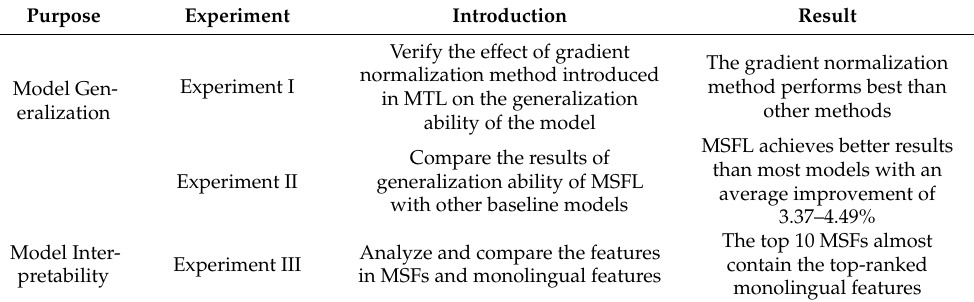
Table 4. The brief conclusion of experiments in our